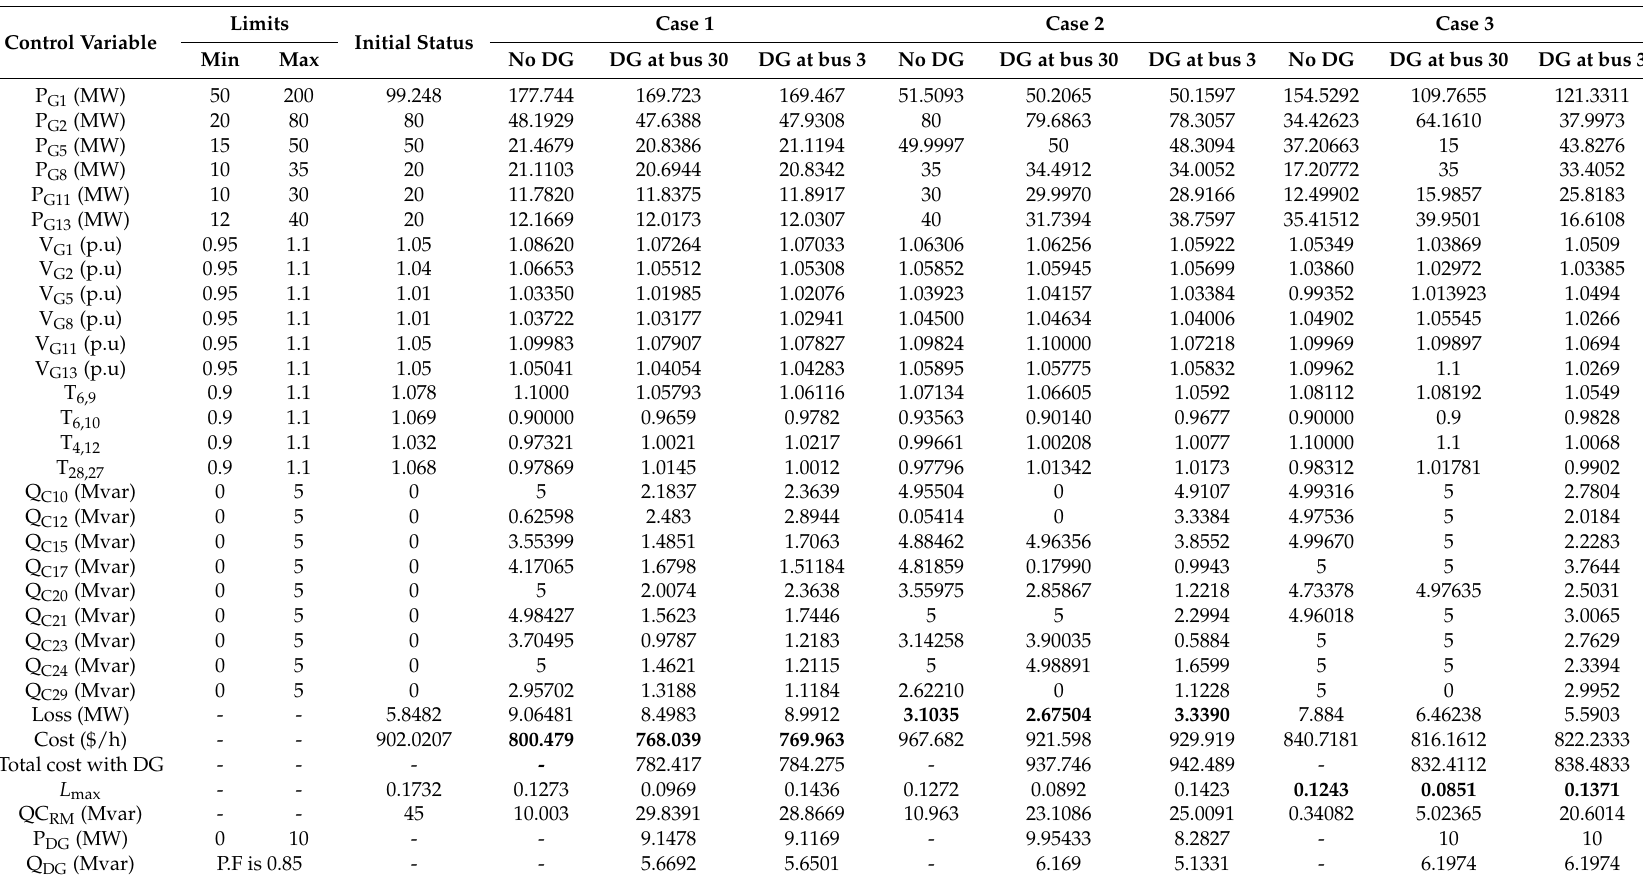
The values in bold type indicate optimum